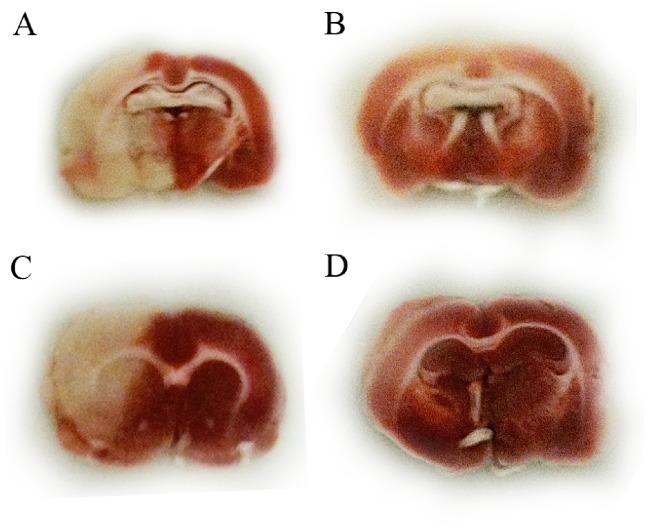
Representative tetrazolium chloride (TTC) stained sections of (A) transient middle cerebral artery occlusion (tMCAo)+rt-PA rats (B) sham+rt-PA rats (C) tMCAo+vehicle rats and (D) sham+vehicle rats.Dark areas reflect living viable tissue while white reflects infarcted tissue or areas of white matter. Infarcted areas occupy at least 50% of the right hemisphere in all tMCAo rats.